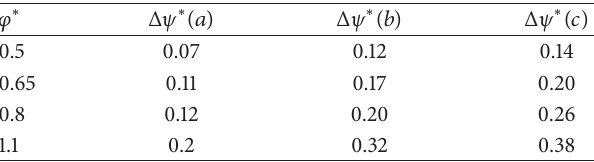
Table 3: Effect of operating point location on reduction of pump head for three viscous fluids: 𝑎 = 35 cSt (Re = 43 × 10 3 ), 𝑏 = 64